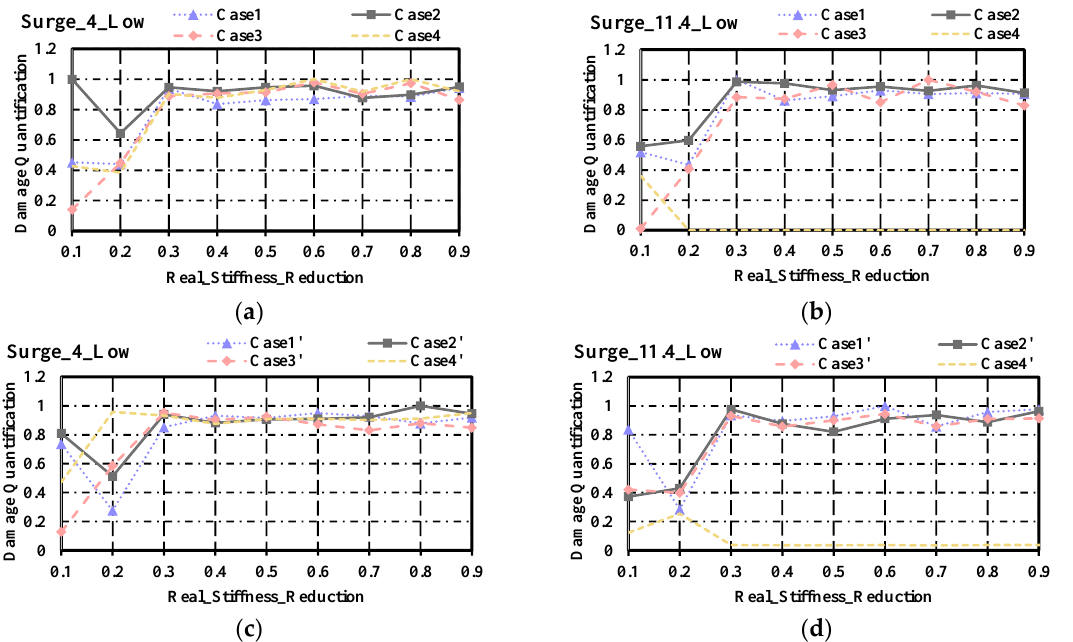
Figure 5. Damage quantification by MSCSA-AED with Euclidean similarity examined under different hyper-parameters. ( a ) Surge acceleration under 4 m/s, measured by the lower sensor using learning rate, was 0.001. ( b ) Surge acceleration under 11.4 m/s, measured by the lower sensor using learning rate, was 0.001. ( c ) Surge acceleration under 4 m/s, measured by the lower sensor using learning rate, was 0.005. ( d ) Surge acceleration under 11.4 m/s, measured by the lower sensor using learning rate, was 0.005. Table 4. Complexity analysis of the models.